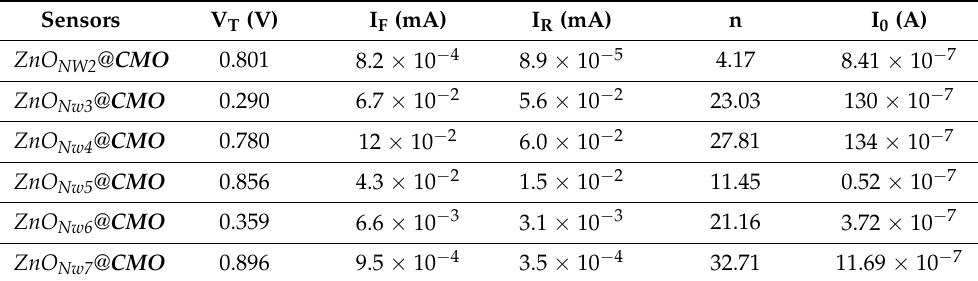
Table 2. Electrical parameters of the as-obtained ZnO Nws @CMO